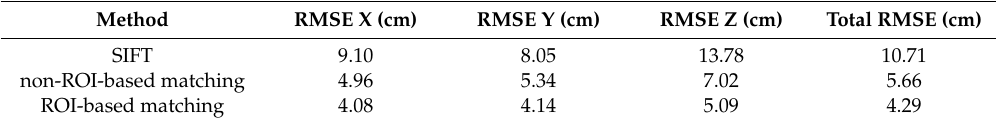
Table 4. Error statistics of checkpoints measured using DSMs. These errors are derived from differencing with checkpoints that serve as a reference. DSMs: digital surface models; RMSE: root mean square error.